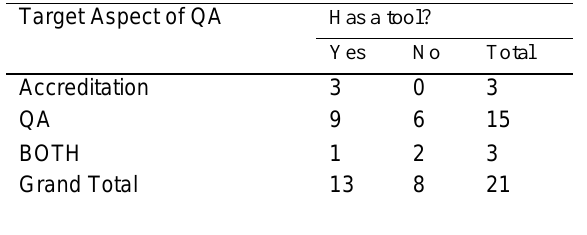
Table 3. Frequency of Studies on tool development and practical experiment design